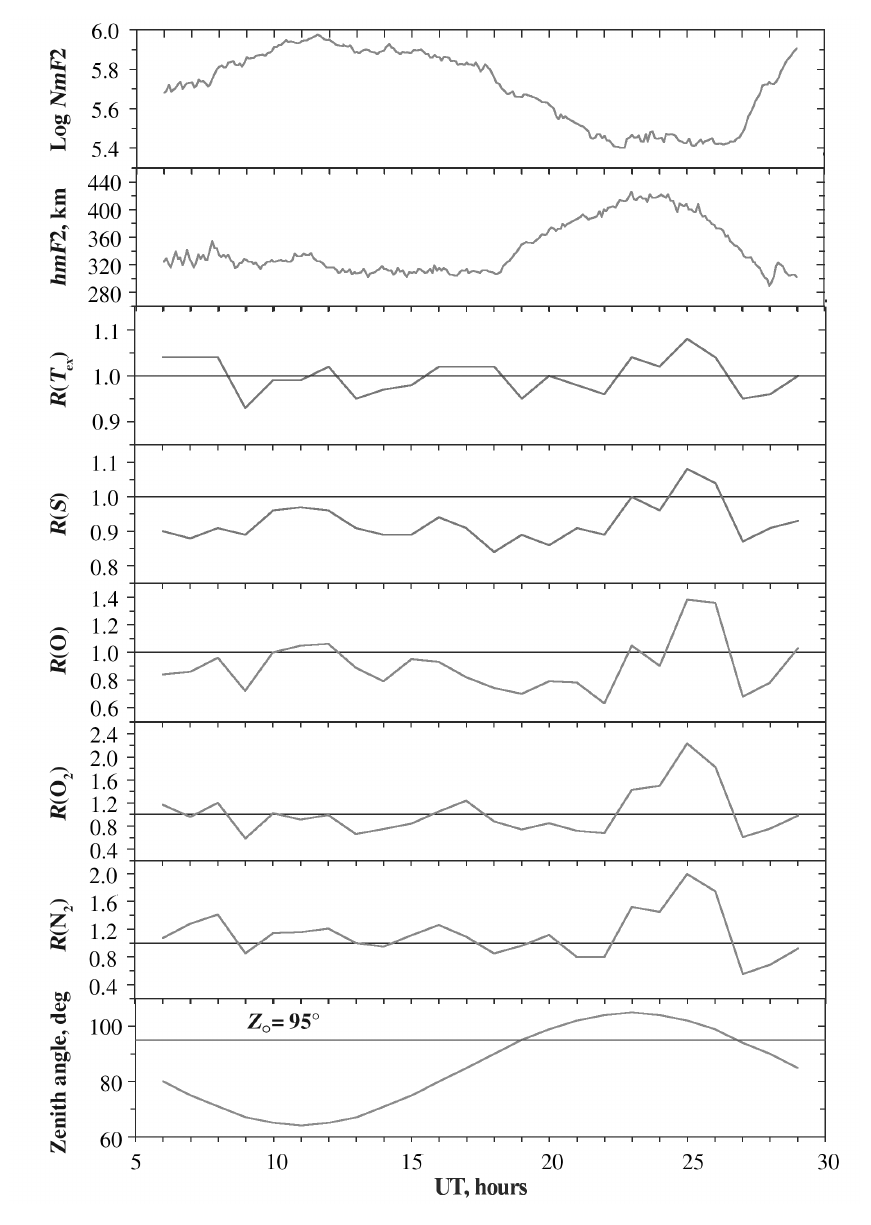
Fig. 4.7. Diurnal variation of calculated T ex , S , O, O 2 , and N 2 to MSIS-86 value ratios. Neutral concentrations are taken at 300 km height. Two upper panels give EISCAT observations of NmF 2 and hmF 2 for a quiet period of April 1-2, 1992. Solar zenith angle variation is given in the bottom